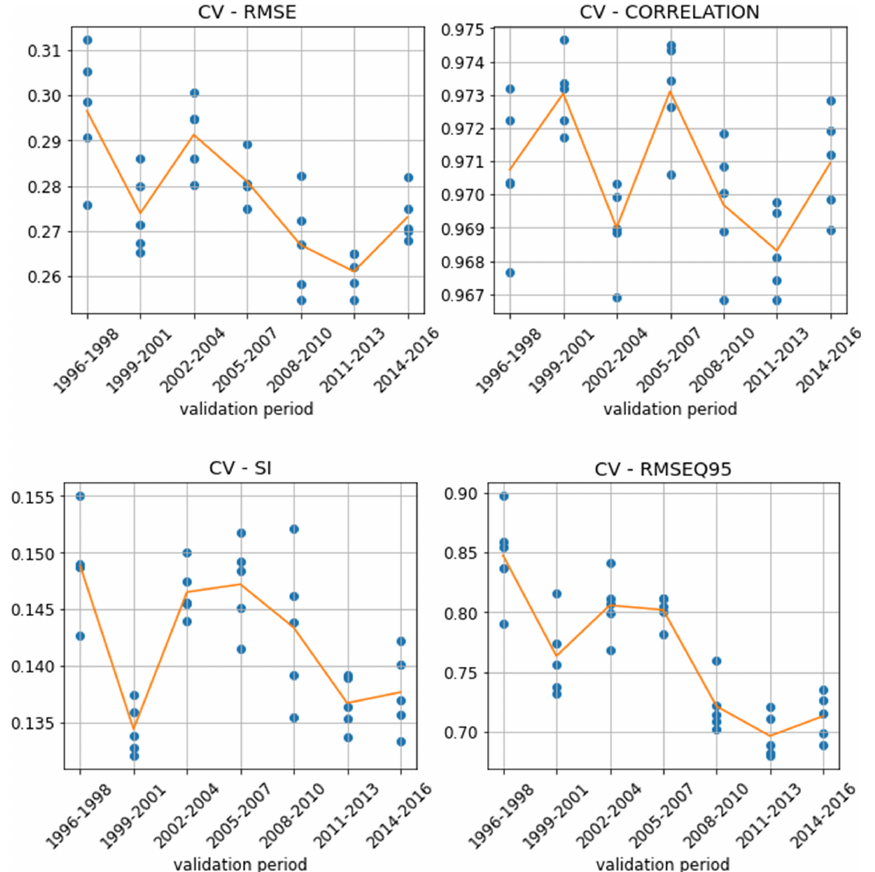
Figure 5. Statistical scores for each fold (the orange curve is the average score for each fold).